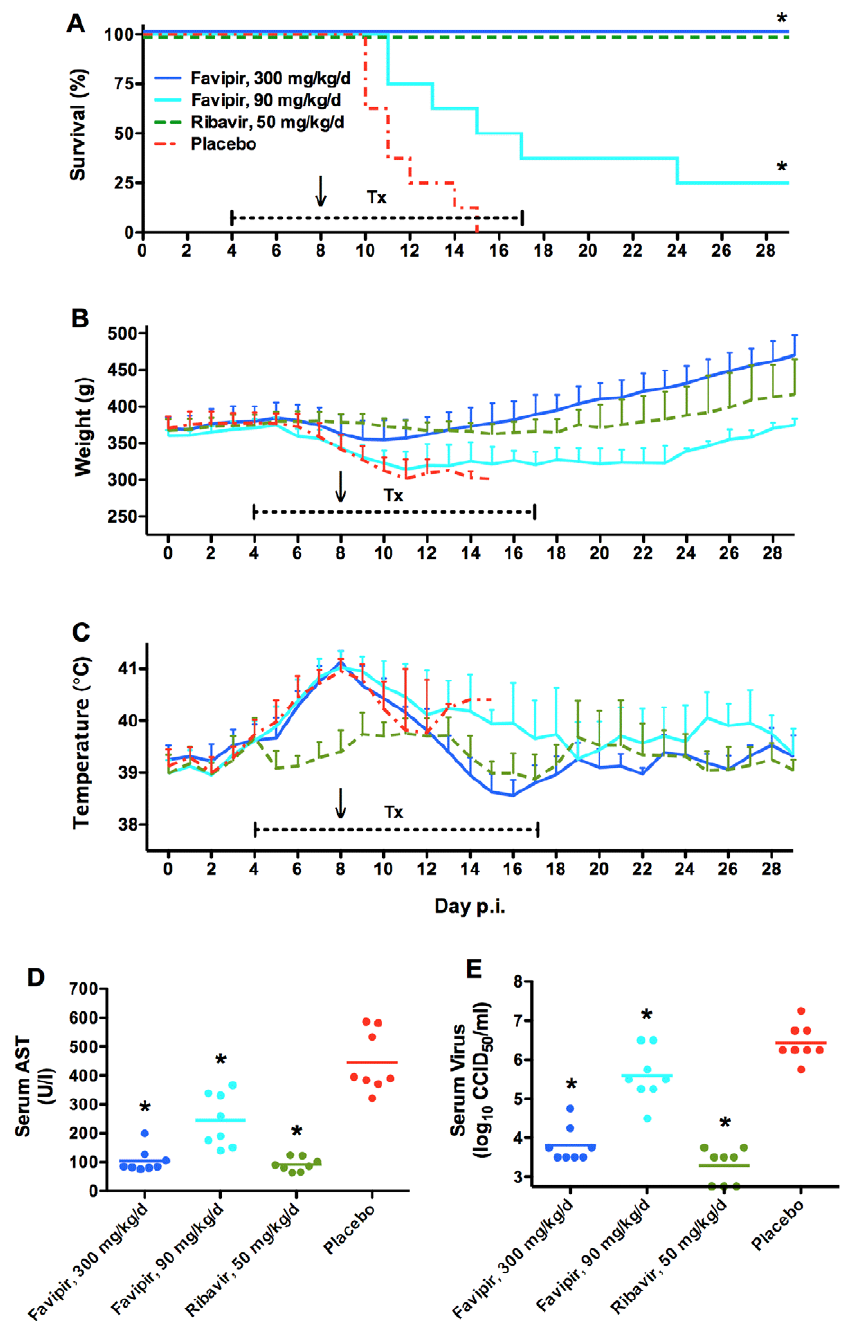
Figure 3. Treatment of lethal PICV infection with favipiravir starting 4 days after challenge. Guinea pigs (n=8/group) challenged with 500 PFU of p19 PICV were treated twice daily for 14 days with favipiravir, ribavirin, or placebo beginning on day 4 of infection (capped hashed line). Animals receiving favipiravir were initially fed 100 and 30 mg/kg/d (days 4 to 7) before increasing the doses to 300 and 90 mg/kg/d, respectively, starting on day 8 (indicated by arrow). (A) Survival, (B) body weights, and (C) temperatures were monitored for 29 days. Serum was collected on day 11 for analysis of (D) AST and (E) viremia, with the exception of two moribund animals from the placebo group that had to be sacrificed on day 10. * P , 0.05 compared to placebo-treated